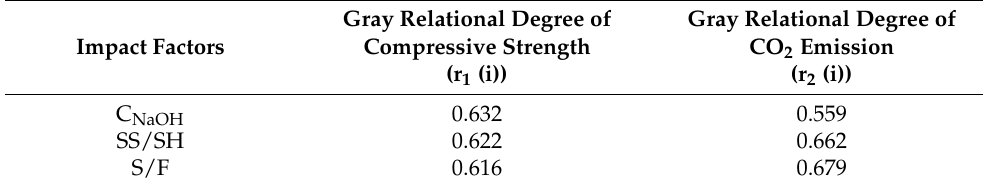
Table 9. Gray relational